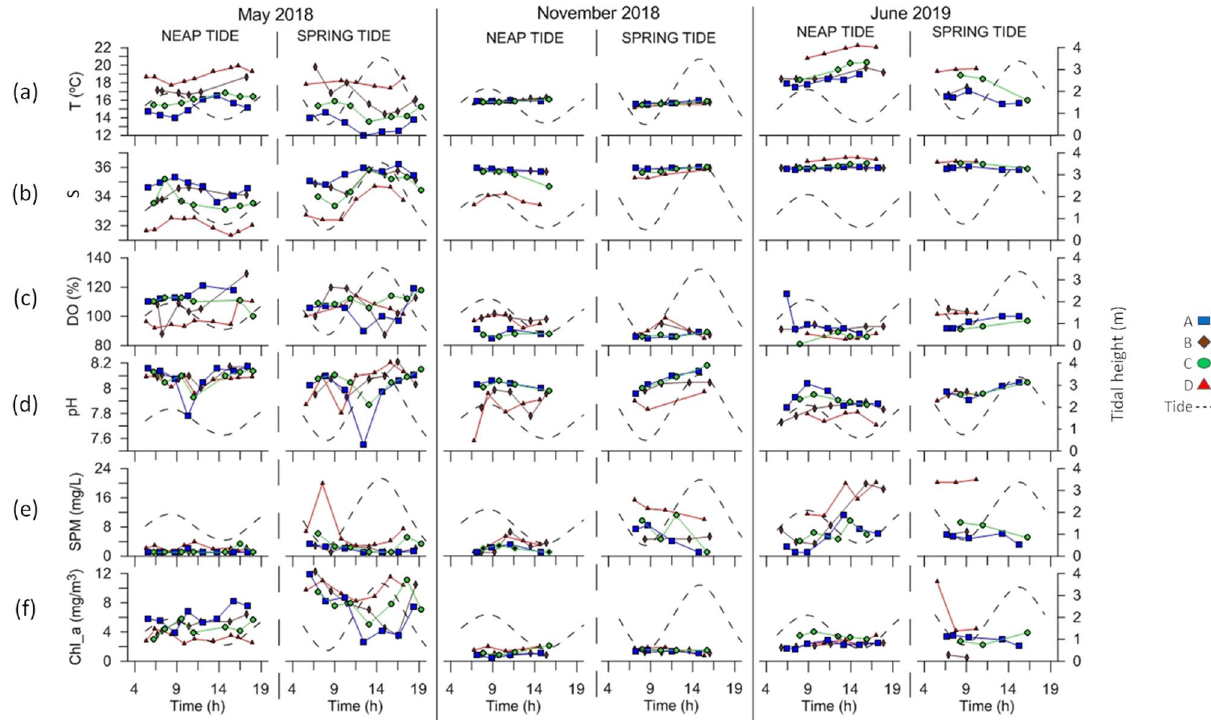
Figure 2. Tidal variability of the temperature (T, °C), salinity (S), dissolved oxygen (DO, %), pH, suspended particulate matter (SPM, mg/L) and chlorophyll a (Chl_ a , mg/m 3 ) observed during the sampling campaigns in neap tide and spring tide conditions. All data were collected at the surface of the water column. The tidal height is represented in grey dashed lines. Sampling stations are colored as follows: A—blue, B—brown, C—green and D—red. The figure was produced using PRIMER 6 (6.1.16) + PERMANOVA (1.0.6) software from PRIMER-e (https:// www. primer- e.